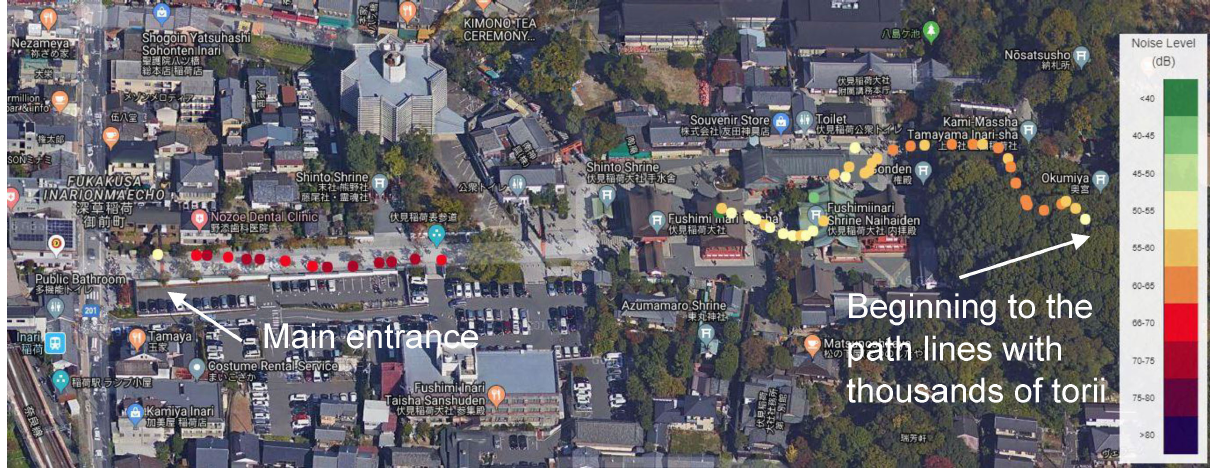
Figure 5: Soundscape from the main entrance opposite the train station to the starting of the path lined with thousands of torii